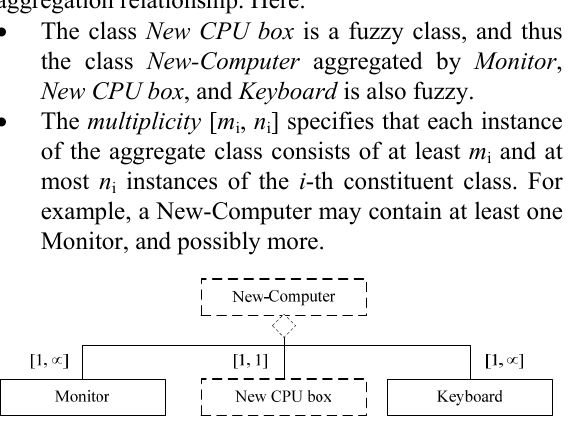
Fig. 3. Representation of a fuzzy aggregation in a fuzzy UML